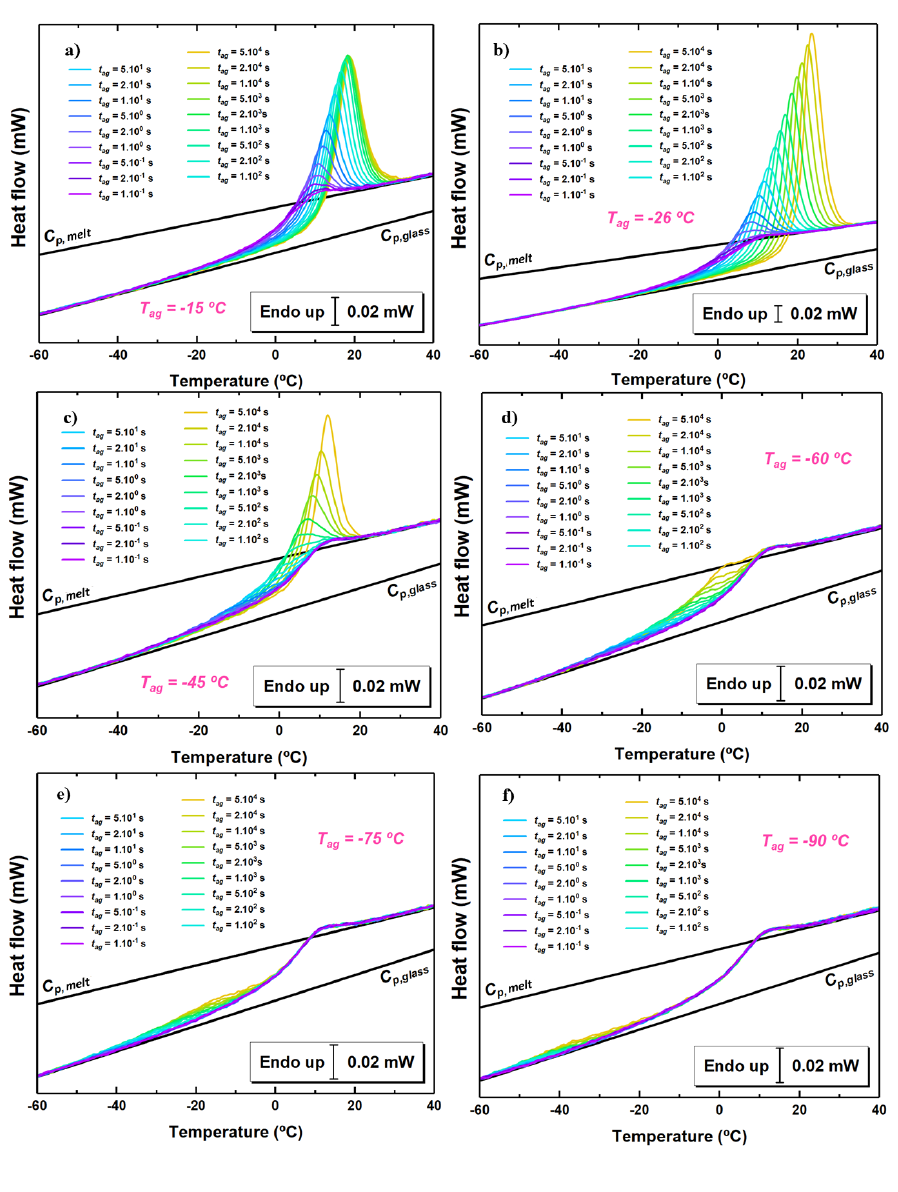
Figure 3. Heat flow rate scans at the indicated times and the following aging